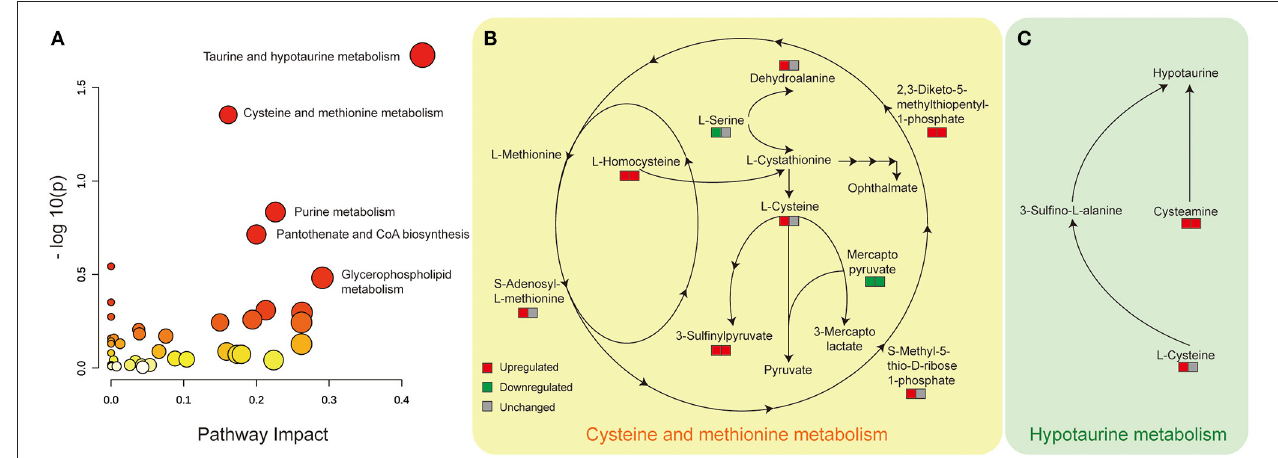
FIGURE 4 | Disturbed cysteine and methionine metabolism and hypotaurine metabolism pathway with significance identified from Metabanalyst in the comparison of DKD vs. DC, DKD-H vs. DKD-M. (A) Disturbed metabolic pathways were identified from the changed metabolites from the comparison of DKD vs. DC and DKD-H vs. DKD-M using serum samples. All matched pathways according to the p values from the pathway enrichment analysis and pathway impact values from the pathway topology analysis. The color of each node (varying from yellow to red) means the metabolites are in the data with different levels of significance, the size of each node represents the pathway impact values. (B) Altered serum metabolites in the cysteine and methionine metabolism pathway. The left square refers to the comparison of DKD vs. DC, the right square refers to the comparison of DKD-H vs. DKD-M. Red means upregulated more than 1.1 fold, Green means downregulated less than 0.91 fold, and gray means unchanged whose range between 0.91 and 1.1 in each comparison. (C) Altered serum metabolites in the hypotaurine metabolism pathway. Refer to (B) for the description of the figure.